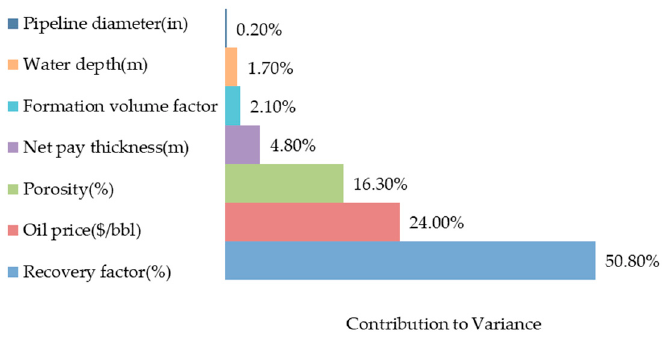
Figure 4. Sensitivity analysis of all parameters.